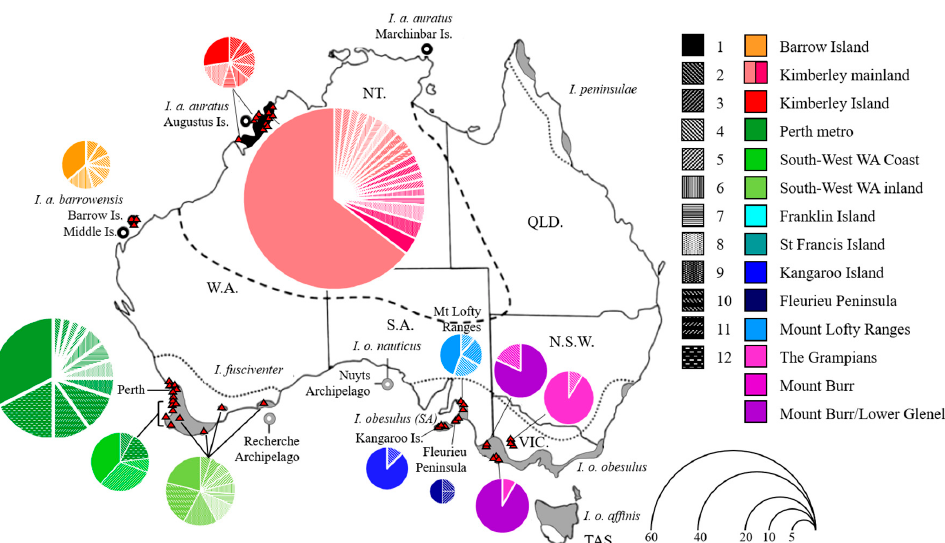
Figure 1. Map of current and historical distribution of Isoodon taxa included in the current study (adapted from Zenger et al. [21]) and geographic distribution of mitochondrial DNA haplotypes. Grey shading represents contemporary distribution of taxa formerly or currently recognised within I. obesulus and black shading represents current distribution of I. auratus . Dotted line indicates historical limits of I. obesulus and dashed lines designate historical I. auratus limits. indicates sampling locations. Each pie chart represents haplotype frequencies within each sampling site, and size of pie chart represents numbers of haplotypes. Colour codes indicate the sites where haplotypes were mostly found. Pattern codes represent individual haplotypes found within each site.